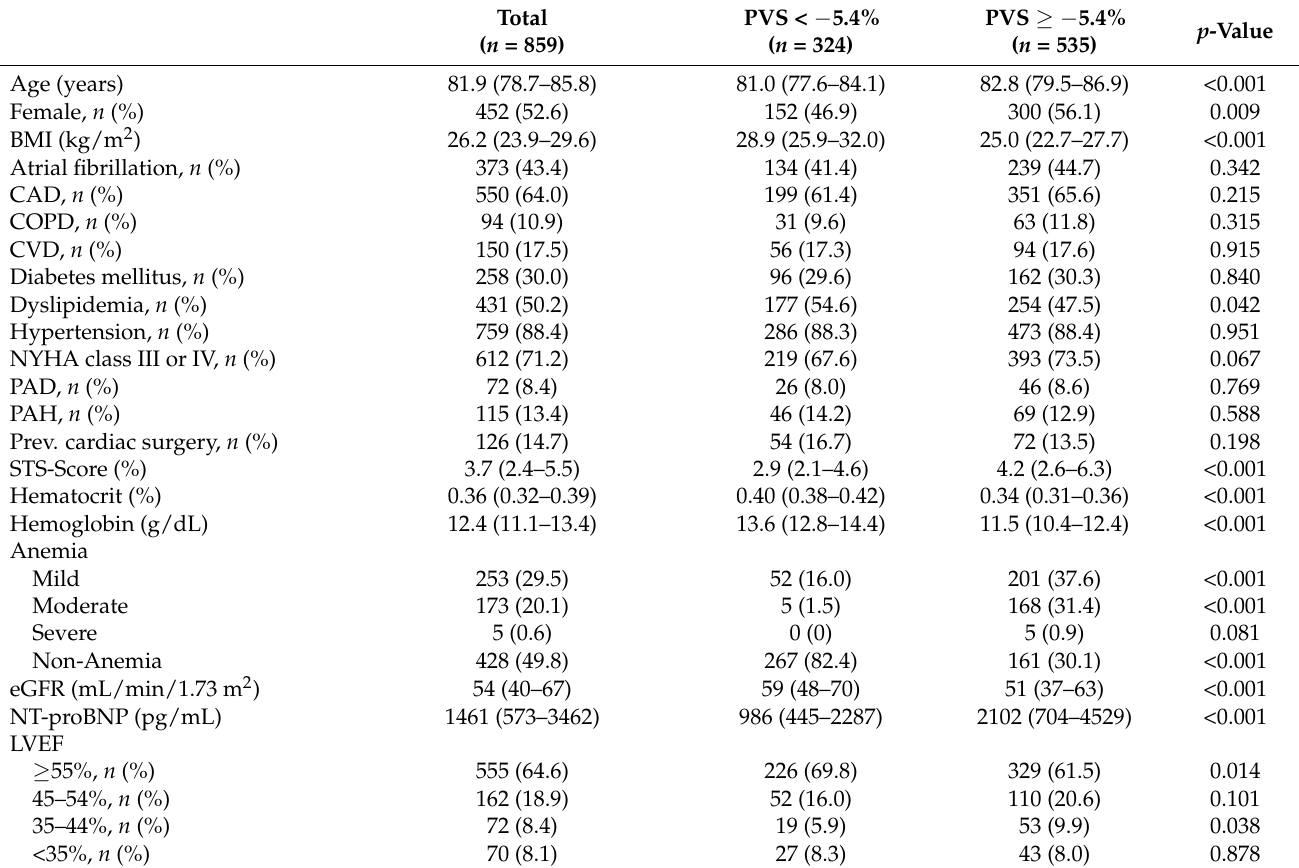
Table 1. Baseline characteristics and heart failure